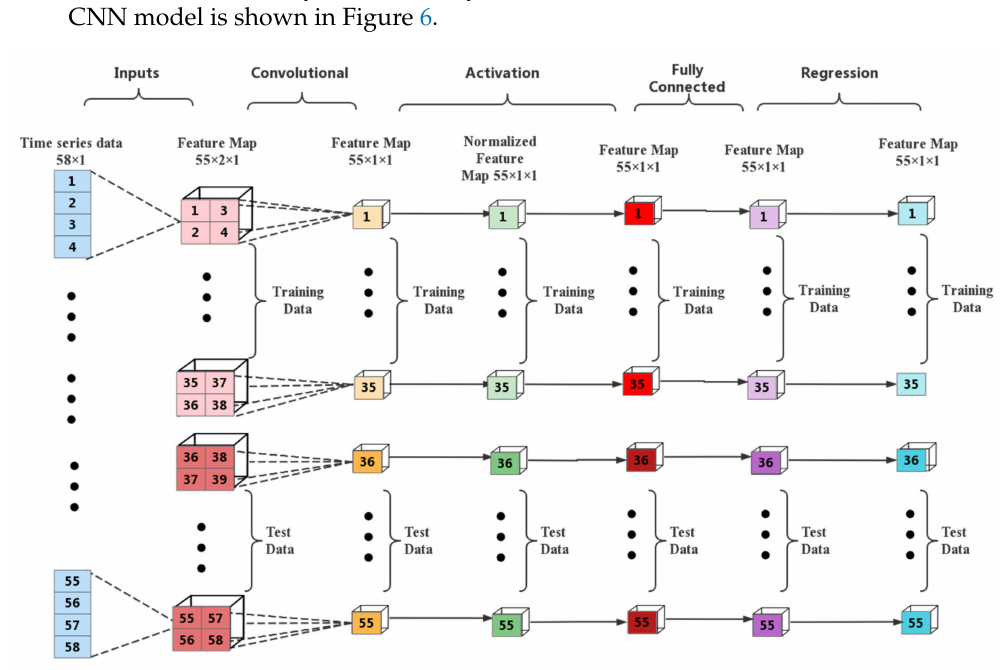
Figure 6. CNN model.